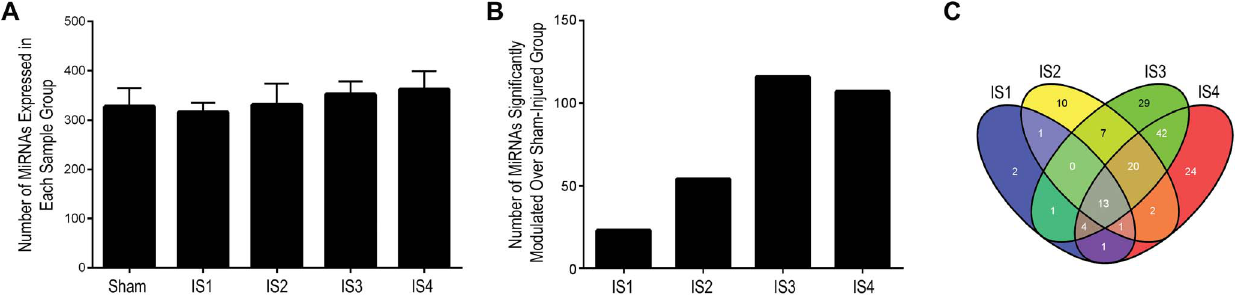
Figure 4. MiRNA expression pattern. ( A ) MiRNAs that show Ct , 36 were considered as expressed. The number of miRNAs expressed ranged from 315.83 2 362.17 with a maximum and minimum numbers detected in IS4 and IS1 respectively. The SD ranged from 19.28 2 43.37, the maximum being in IS2 and the minimum in IS1. The values are presented as Mean 6 SD of the number of miRNAs detected in each group. (B) The number of miRNAs that were significantly modulated ( $ 1.5 fold; P , 0.05) following the injury over the time point matched sham controls increased with the height and weight of the free falling metal rod except in the IS3 group where the number of significantly modulated miRNAs was marginally greater than the IS4 group. (C) Overlapping miRNA data analysis for significantly modulated miRNAs in the injury groups was done using the online Venn diagram generation tool [Oliveros (2007). VENNY. An interactive tool for comparing lists with Venn Diagrams. http://bioinfogp.cnb.csic.es/tools/venny/index. html].